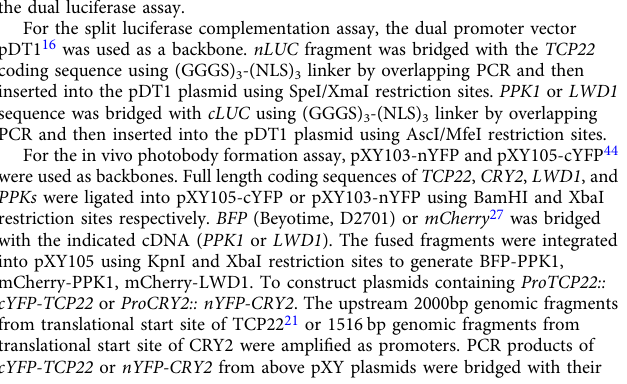
Fig. 6 Hypothetical model for CCA1 activation by CRY2. a Possible mechanism by which CRY2 mediates blue light input to the clock central oscillator via photobody formation. b Our study demonstrates that CRY2, TCP22, PPKs, and LWDs could positively regulate CCA1 under blue